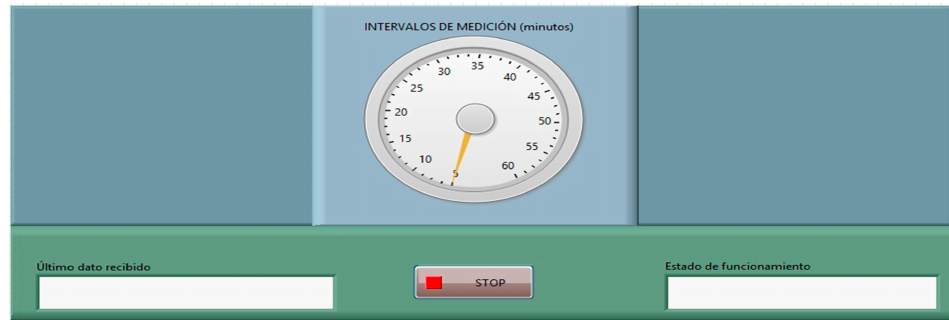
6 of 21 Figure 3. Photograph of one of the nodes installed in the beehive. 3.2. Local Data Server, and Supervisory Control and Data Acquisition System Two applications are executed on the local computer located in each apiary: a supervisory control and data acquisition system (SCADA), which synchronizes, requests, and processes the data of the node in each beehive, and MySQL, the world’s most popular open source database [35]. MySQL is also executed in the cloud data server, and a replica of the local database of each hive is carried out. This server guarantees an extra level of security in the event of a communications failure, since it stores and sends the data acquired in each beehive to the cloud. The local computer is an embedded industrial computer, which shows a higher protection against environmental conditions, as it must be placed beside the beehives. The computer communicates directly with the coordinator node of the wireless network using a USB interface, as shown in Figure 4. We used Libelium’s “XBee USB-Serial gateway” module as the coordinator of the network and gateway [36]. Figure 4. Local database server. The software used for the execution of the SCADA was developed under Laboratory Virtual